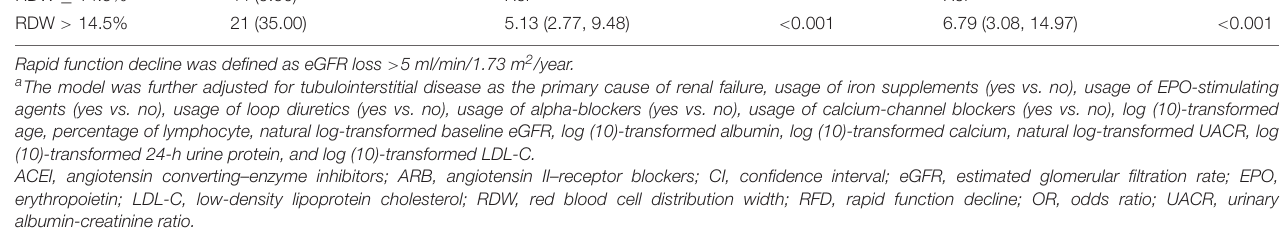
TABLE 4 | Hazard ratios (95% CI) for composite kidney outcomes over the entire study period.